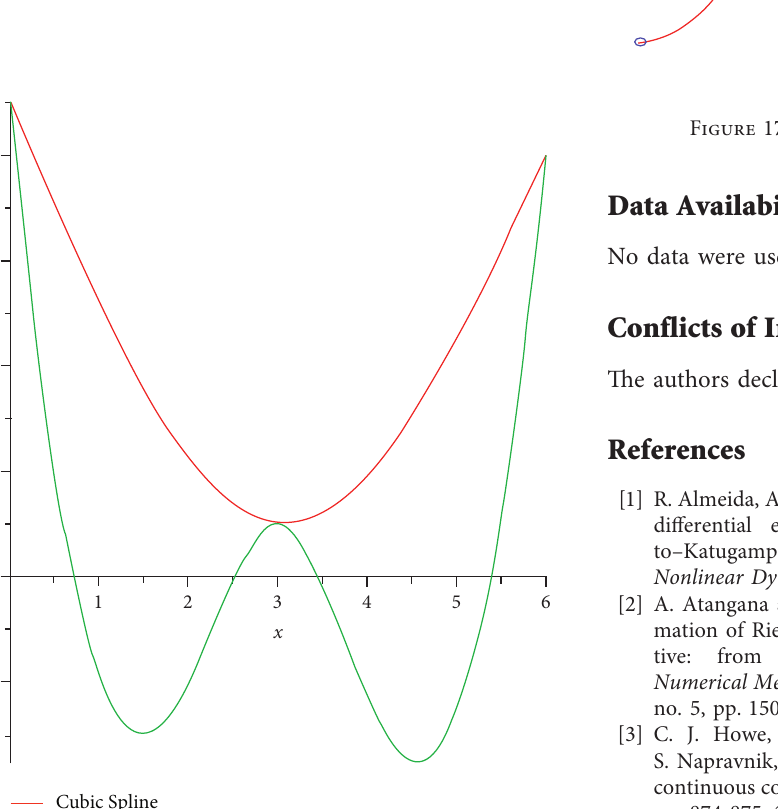
Figure 14: Piecewise curves can be manipulated by the choice of shape parameters 2.